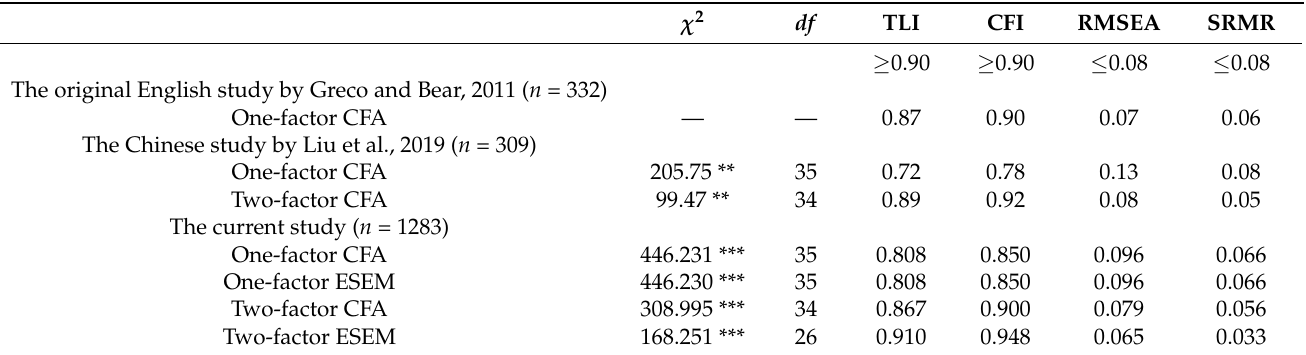
Table 2. Test of goodness of fit of the original and Chinese versions of the CAMM for children and adolescents.